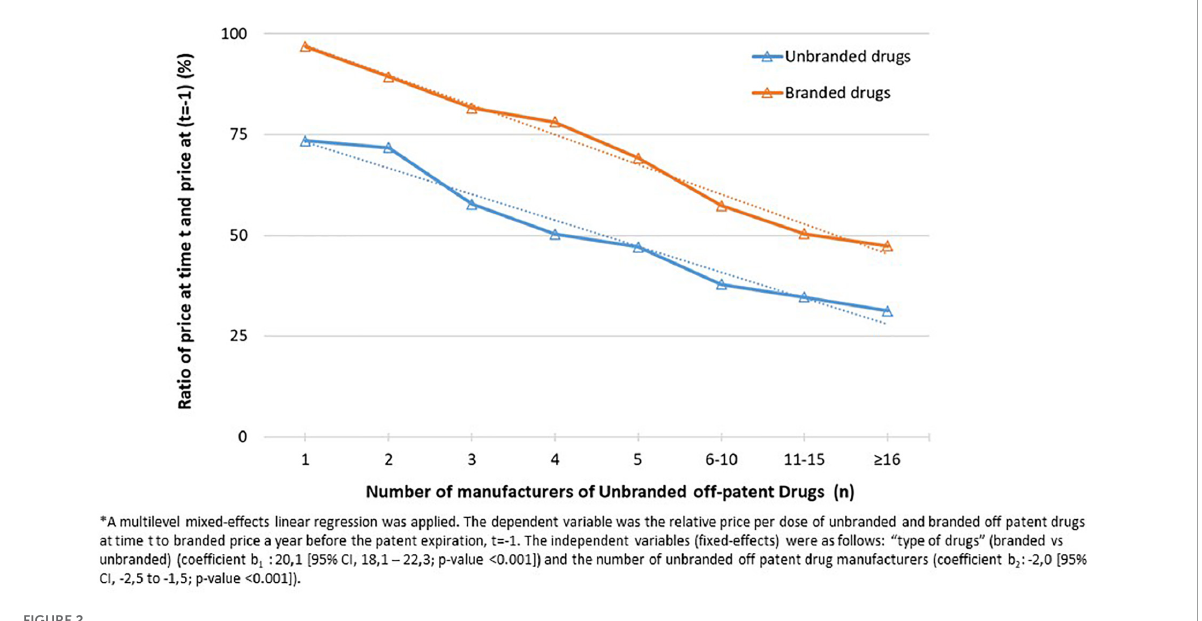
FIGURE2 Relative price per dose of unbranded and branded off patent drugs at time t ( t = 2013, 2018) to branded price a year before the patent expiration, t = –1 (i.e., 12 months before the index date) aggregated by number of unbranded off patent drug manufacturers.